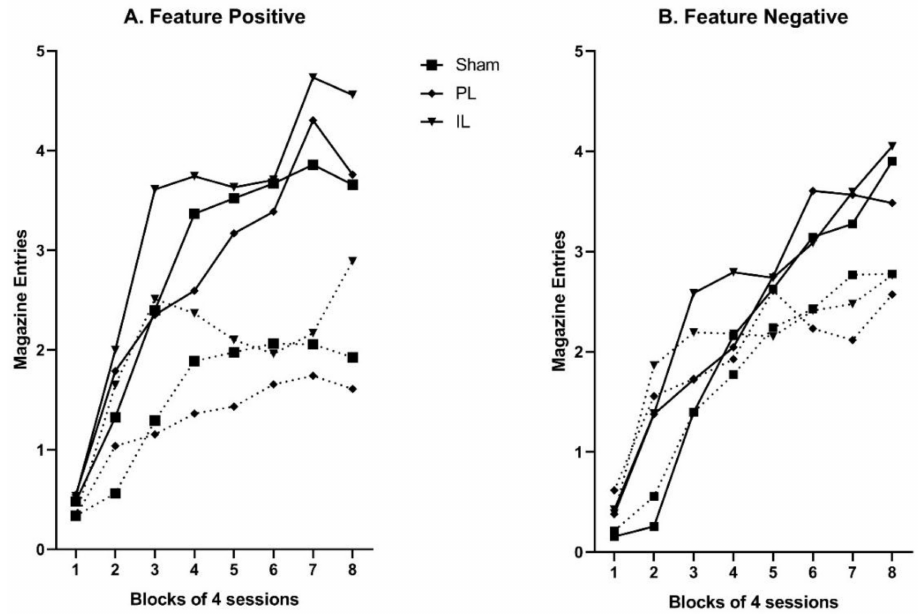
Figure 2. Acquisition of magazine entry responding (rate per 10 s) during target cue presentation in the feature positive (panel A ) and feature negative (panel B ) discriminations. Solid line displays responding to the reinforced target (i.e., on (Y) B + trials for feature positive and A + trials for feature negative), while dotted line displays responding to the non-reinforced target (i.e., B − trials for the feature positive and (X) A − trials for feature negative).